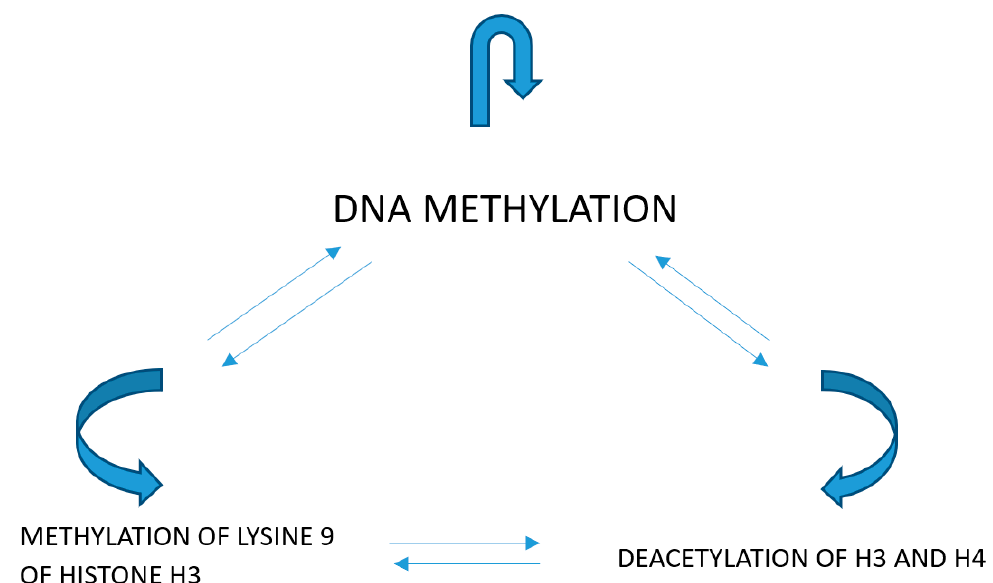
Figure 2. Methylation of lysine 9 of histone H3 causes the deacetylation of histones and methylation of DNA. DNA methylation and methylation of lysine 9 of histone H3 is a consequence of the deacetylation of histones. Methylation of DNA causes the deacetylation of histones and methylation of lysine 9 of histone H3.